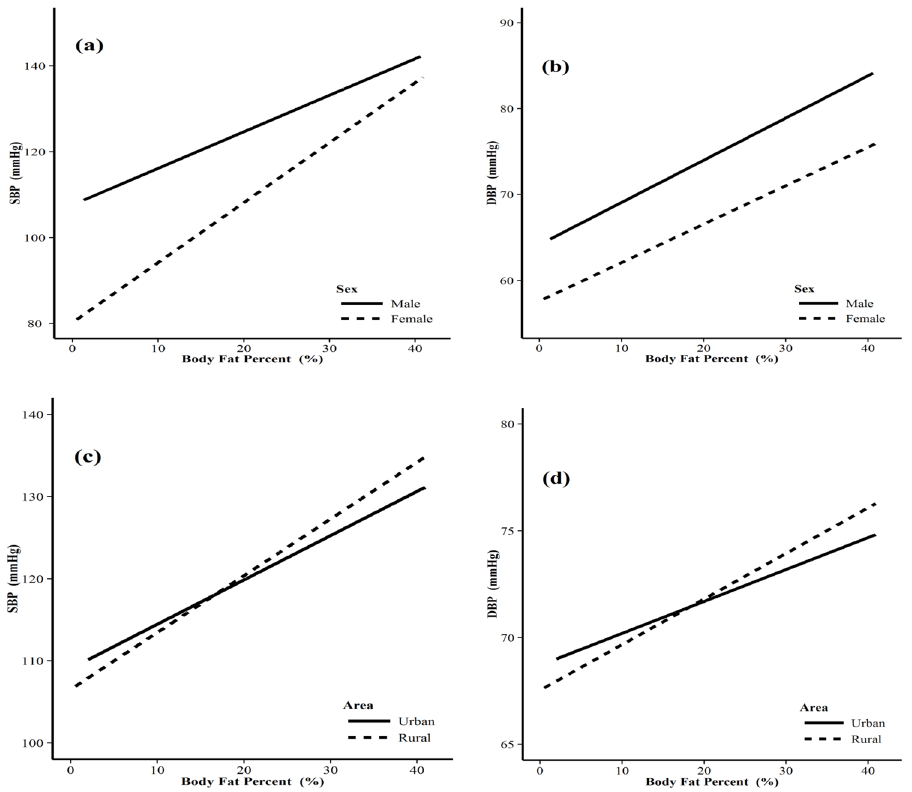
Fig 2. Mean systolic and diastolic blood pressure by BFP between different gender and areas. (a) mean SBP by BFP between different genders; (b) mean DBP by BFP between different genders; (c) mean SBP by BFP between different areas; (b) mean DBP by BFP between different